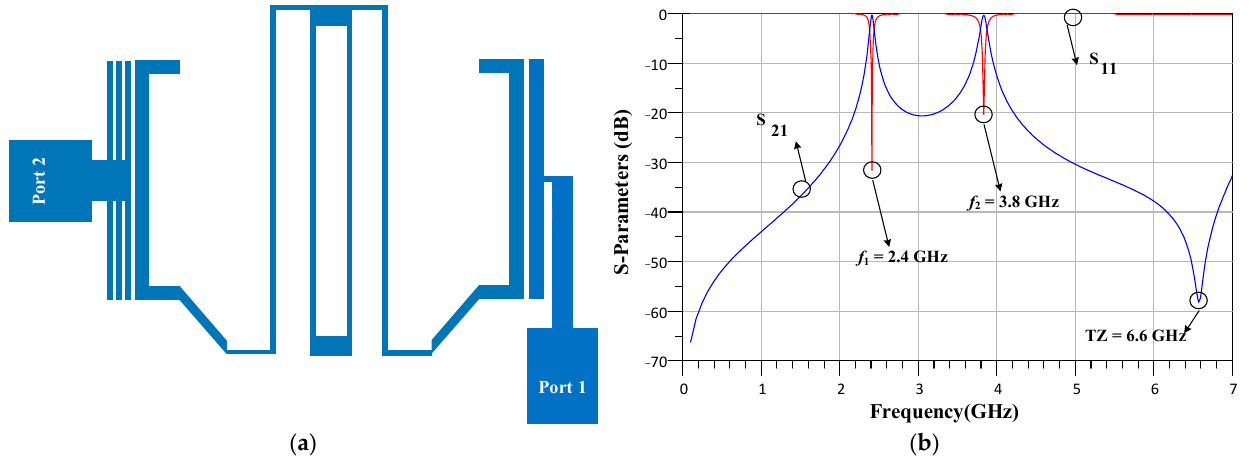
Figure 1. The ( a ) structure and ( b ) response of resonator1. At the second step, triangular loop resonators and Pi-shaped resonators are incorpo- rated to form resonator2. The structure and response of resonator2 are depicted in Figure 2a,b. Resonator2 provides two operating bands at 1.9 GHz and 5.2 GHz. As seen, resona- tor2 cannot provide a stopband with high attenuation level.